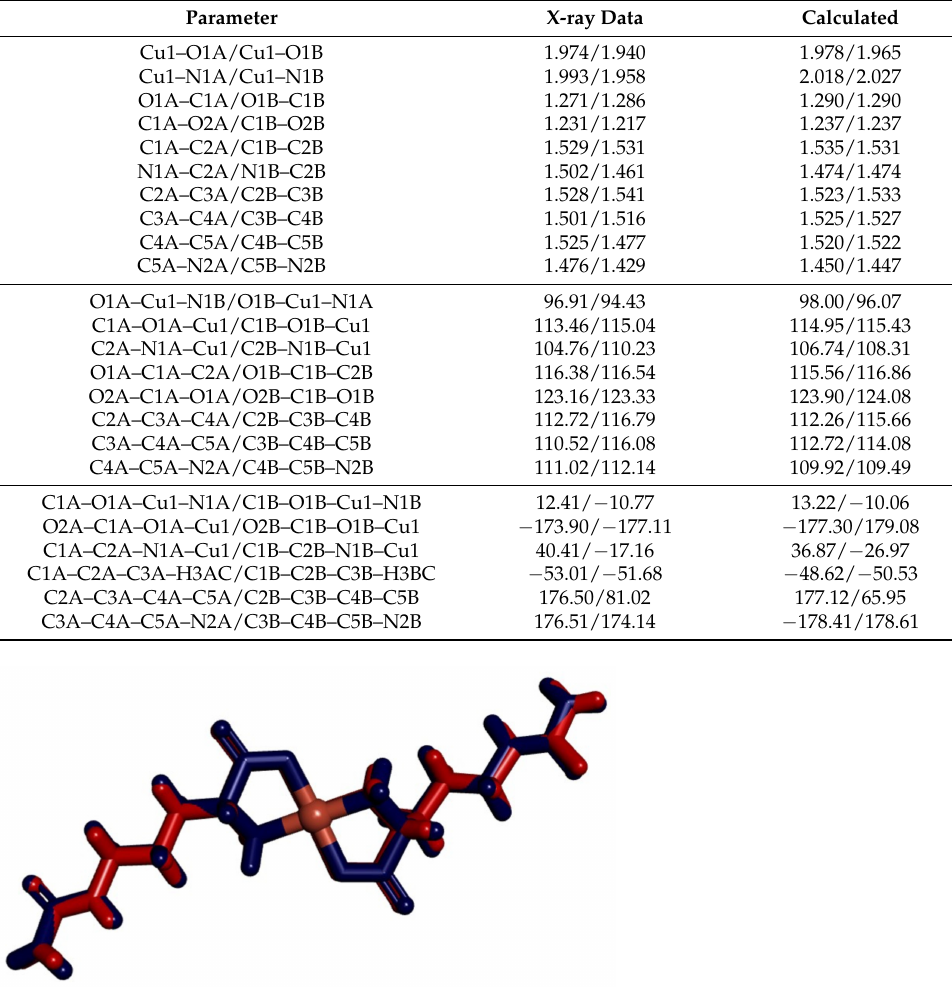
Figure 4. View of the X-ray complex and the optimized complex of [Cu(Citr) 2 ] fitted. X-ray complex is shown in red and calculated complex in